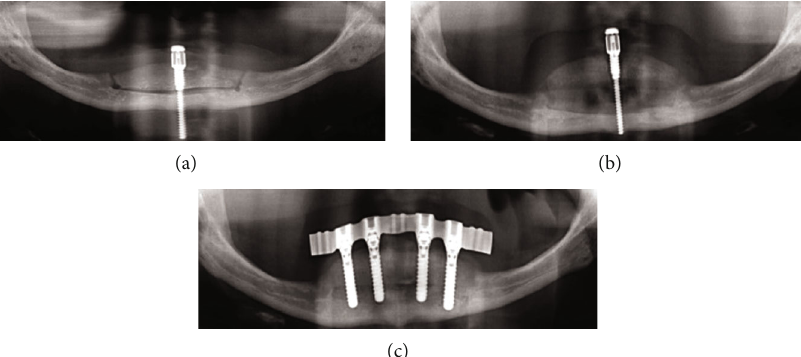
Figure 3: Orthopantomography follow-up. (a) X-ray performed after the placement of the Endo-Distraction device with an initial gap between the osteotomized segments. (b) X-ray showing bone formation after 6 months of retention period. (c) Posttreatment X-ray with fully functional implants connected by a